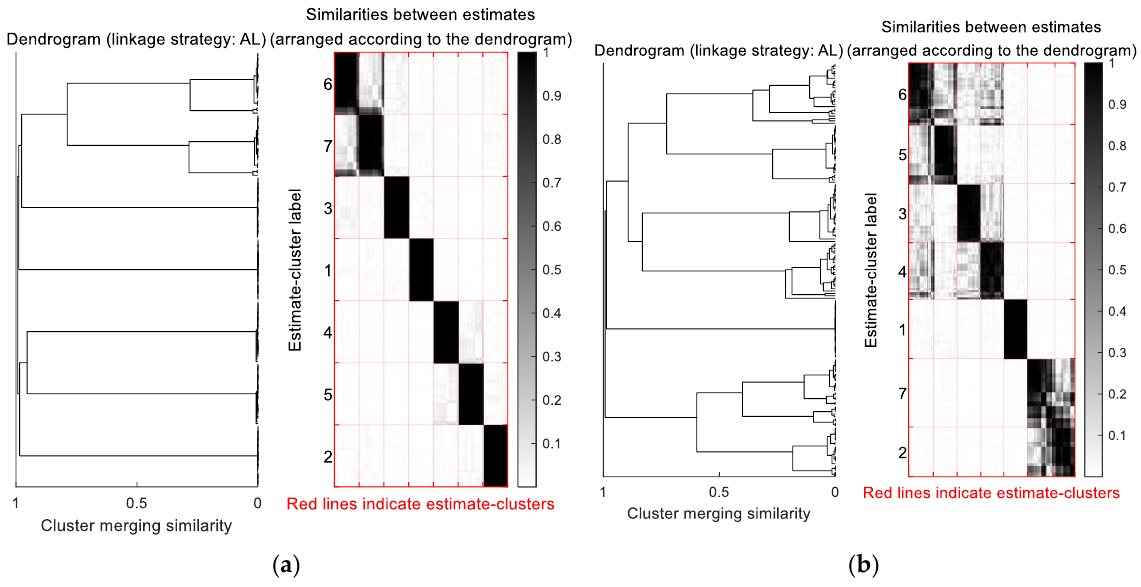
Figure 4. An illustration of independent component clustering for AB14 ( a ) and AB30 ( b ). For AB14 ( a ), the left panel shows that the points can become a cluster when moving left in the dendrogram. The right panel shows that the estimated independent components are divided into clusters, and the grayscale in the graph represents interrelationships between each IC. Table 2. The clusters divided by Icasso for the 12 subjects and the sensor locations corresponding to the independent components.